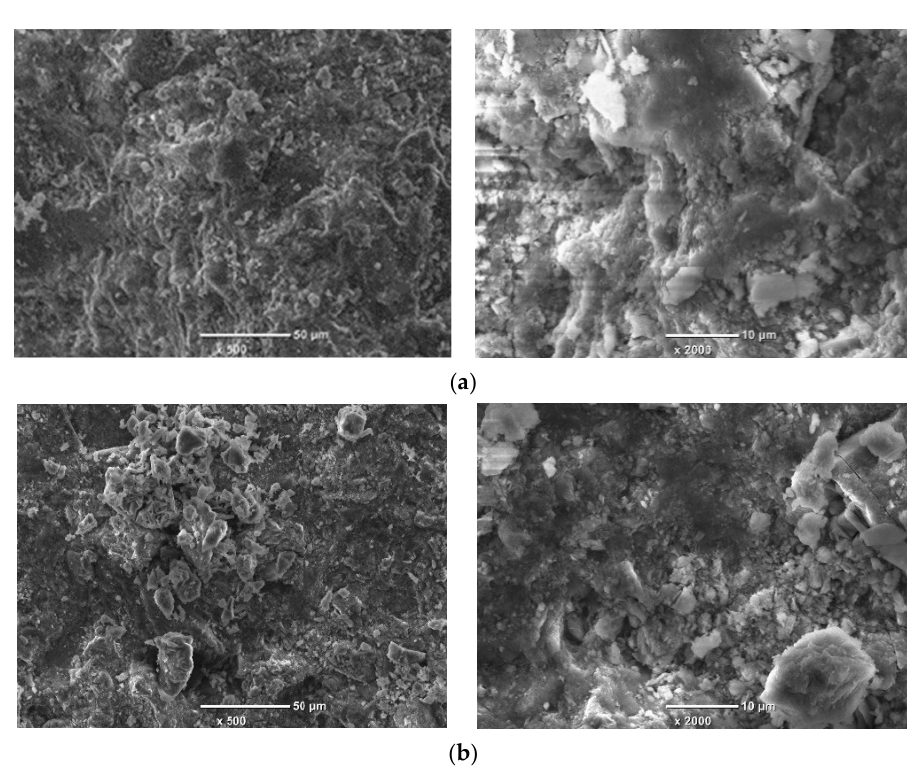
Figure 2. SEM images of ( a ) natural and ( b ) modified zeolite.